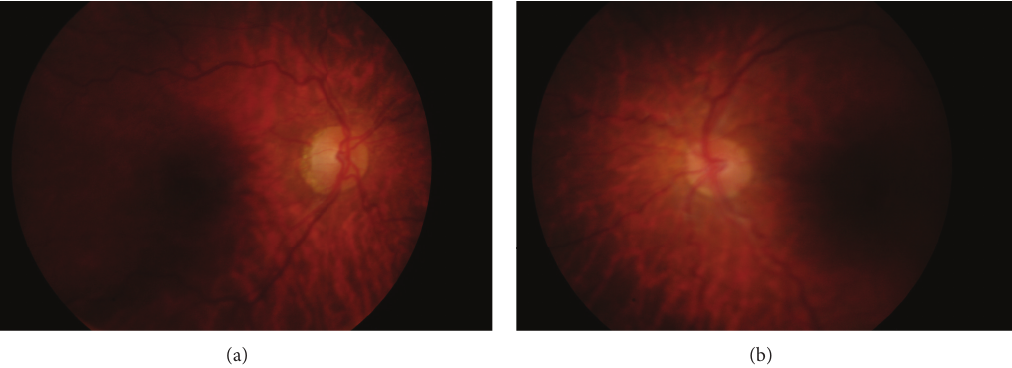
Figure 4: Retinal pigment epithelium alteration and increased venous tortuosity in the right eye (a) and in the left eye (b).